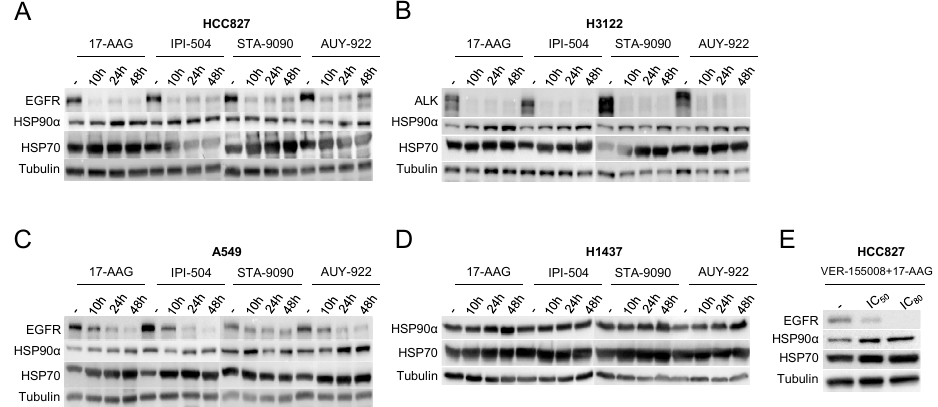
Figure 2. Analysis of sensitivity of adenocarcinoma cell lines to HSP90 inhibitors. Western blot determination of the e ff ect of 17-AAG, IPI-504, STA-9090 and AUY-922 inhibitors on adenocarcinoma cell lines characterized by ( A ) mutated EGFR, ( B ) EML4-ALK translocation, ( C ) mutated KRAS and ( D ) EGFR, ALK and KRAS wild-type. ( E ) Study of combined treatment of HSP70 and HSP90 inhibitors in the HCC827 cell line. HSP90 α and HSP70 expression was determined in each of the cell lines along with the HSP90 clients EGFR and EML4-ALK. For Western blots, a representative image is shown. Densitometry analysis may be found in Figure